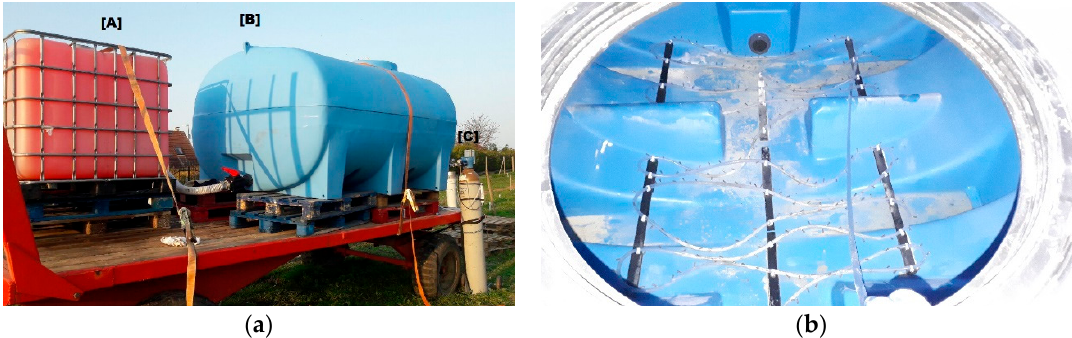
Figure 8. Views of the two tanks and the helium saturation device: ( a ) View of the 1 m 3 tracers tank [A], the 5 m 3 He saturated tank [B] and the compressed He cylinder [C] ; ( b ) View from the manhole of the bubbling device in the 5 m 3 He tank (20 m of PVC pipe pierced with 200 needles of 0.5 mm diameter).